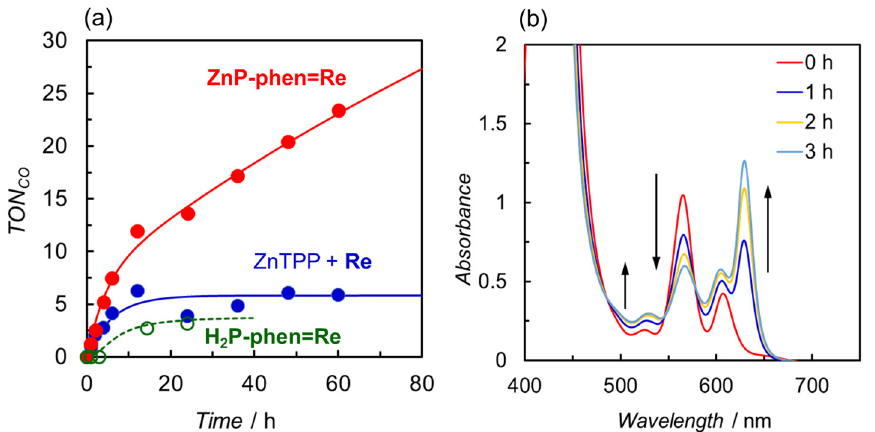
Figure 11. ( a ) Time dependences of CO formation during irradiation of CO 2 -saturated DMA solutions containing TEA in the presence of ZnP-phen=Re , H 2 P-phen=Re , or a mixed system of ZnTPP and fac -Re(phen)(CO) 3 Br ( Re ) under irradiation at 420 nm. ( b ) UV–vis absorption spectral change in ZnP-phen=Re during the irradiation.